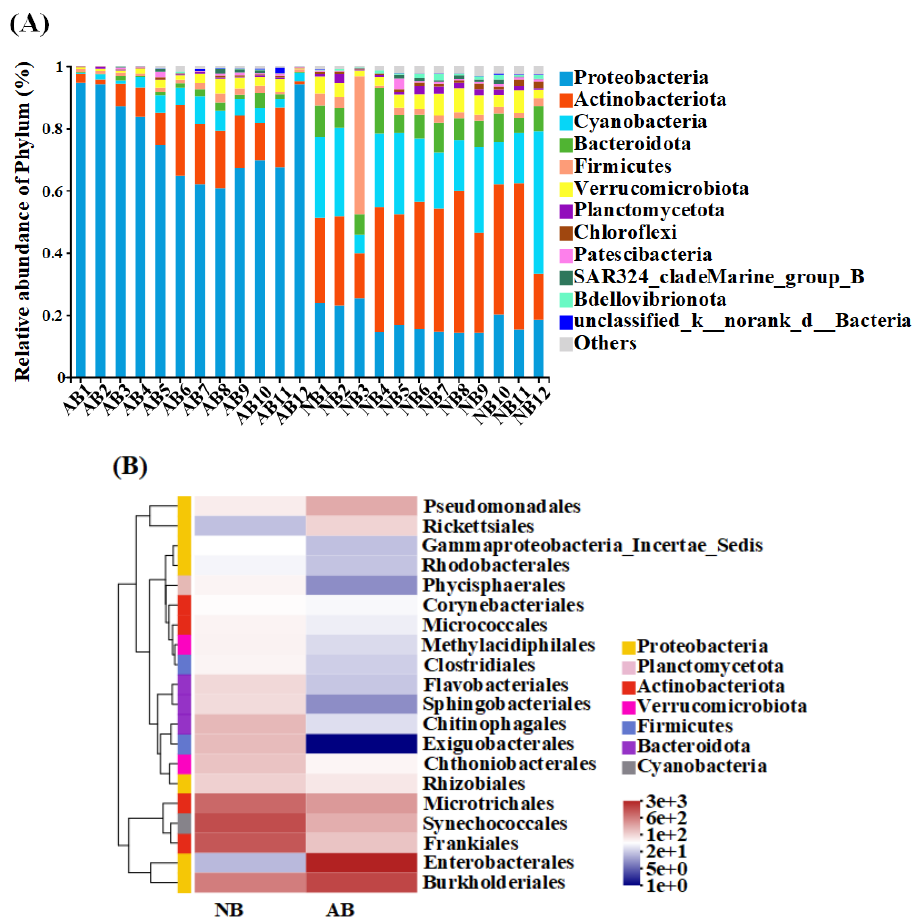
Figure 2. Relative abundance of the community composition of B. calyciflorus -associated bacteria and bacterioplankton. ( A ) Community barplot analysis at the phylum level. ( B ) Community heatmap analysis on the order level.